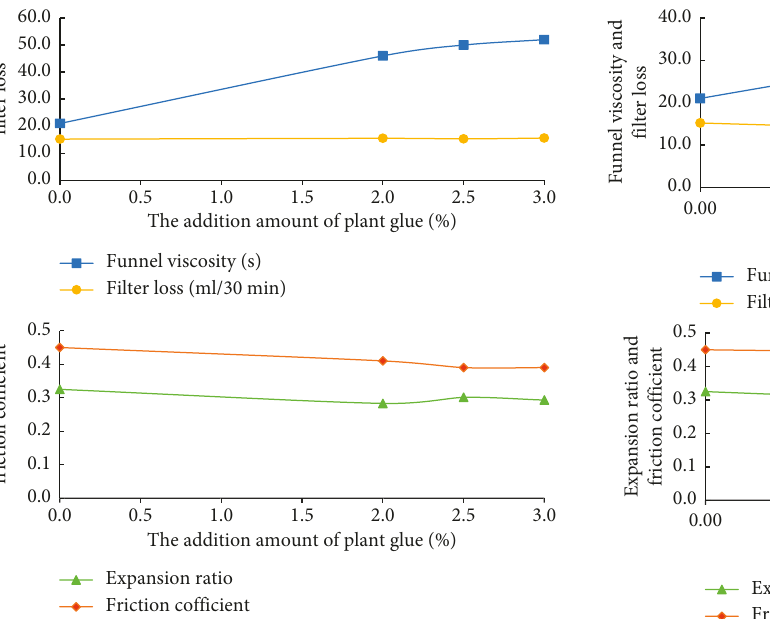
Figure 4: The effect of Na-CMC on the slurry properties.